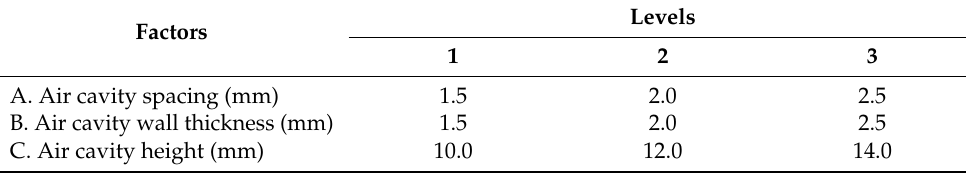
Table 1. Parameter design of the orthogonal test.